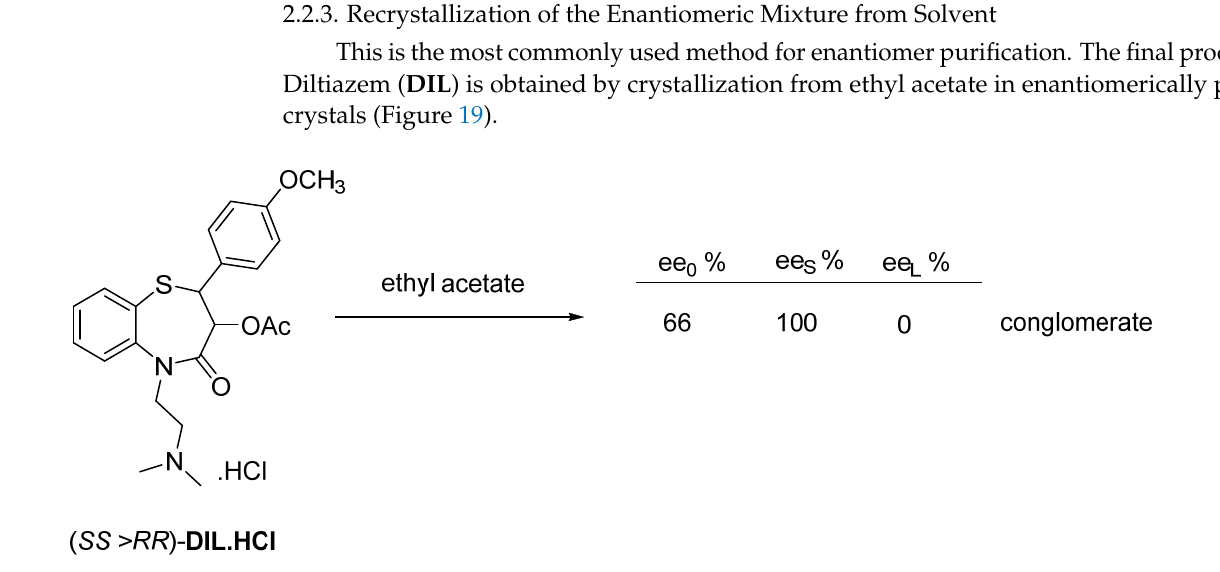
Figure 18. The S enantiomer of FTHQ crystallizes out of melt.